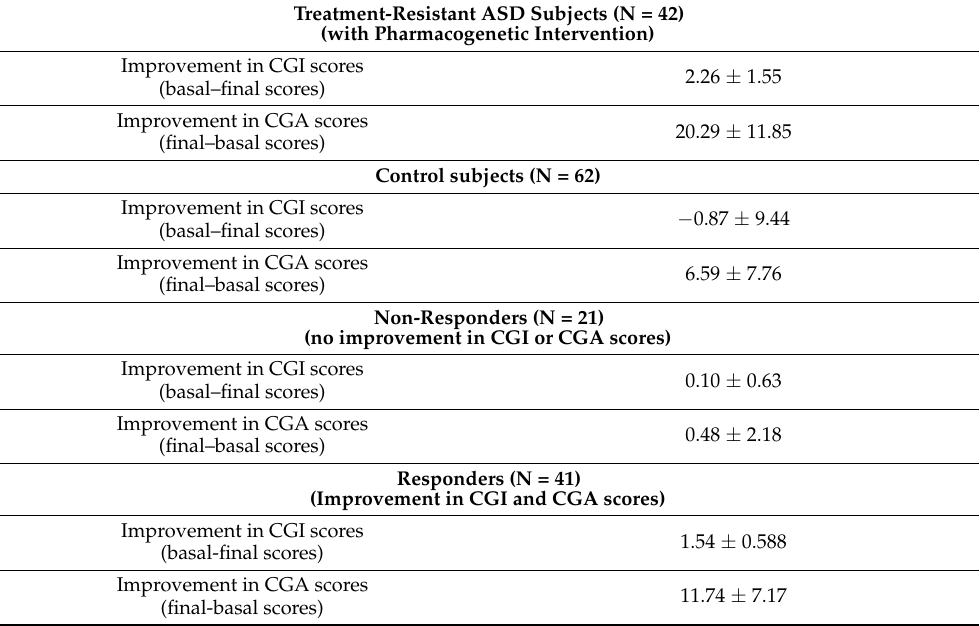
Table 5. Differences in CGI and CGA scores in the treatment-resistant and control groups observed after 12 weeks of